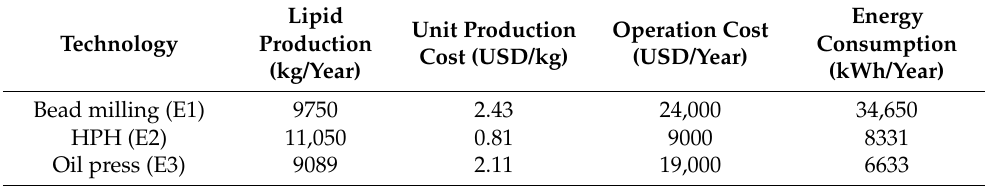
Table 5. Individual evaluation of cell disruption